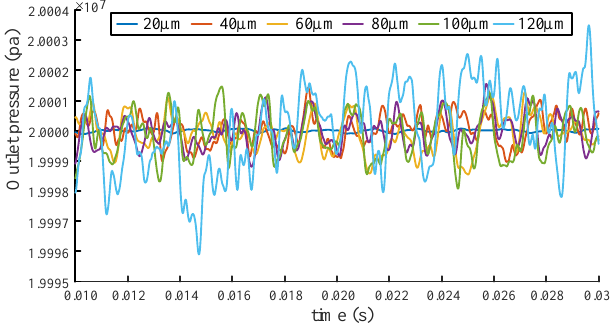
Figure 12. Pressure pulsation curve under different radial wear gaps.